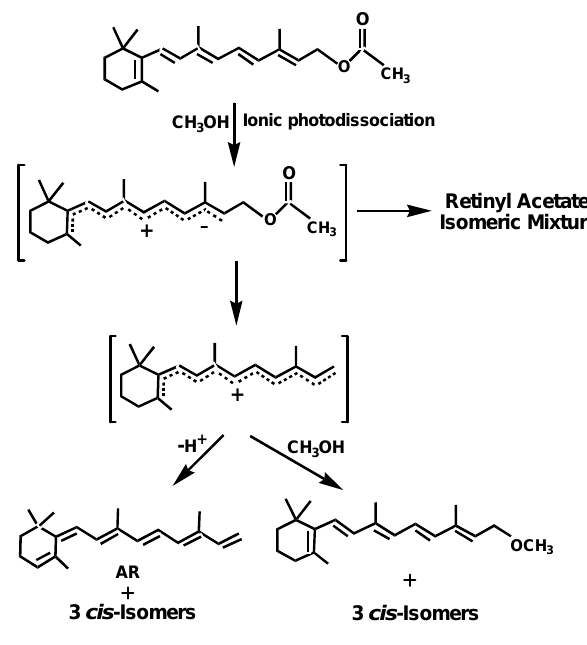
Figure 6: Ionic photodissociation mechanism of isomerization of retinyl acetate under UVA light irradiation to cis -retinyl acetate and a mixture of cis - and trans